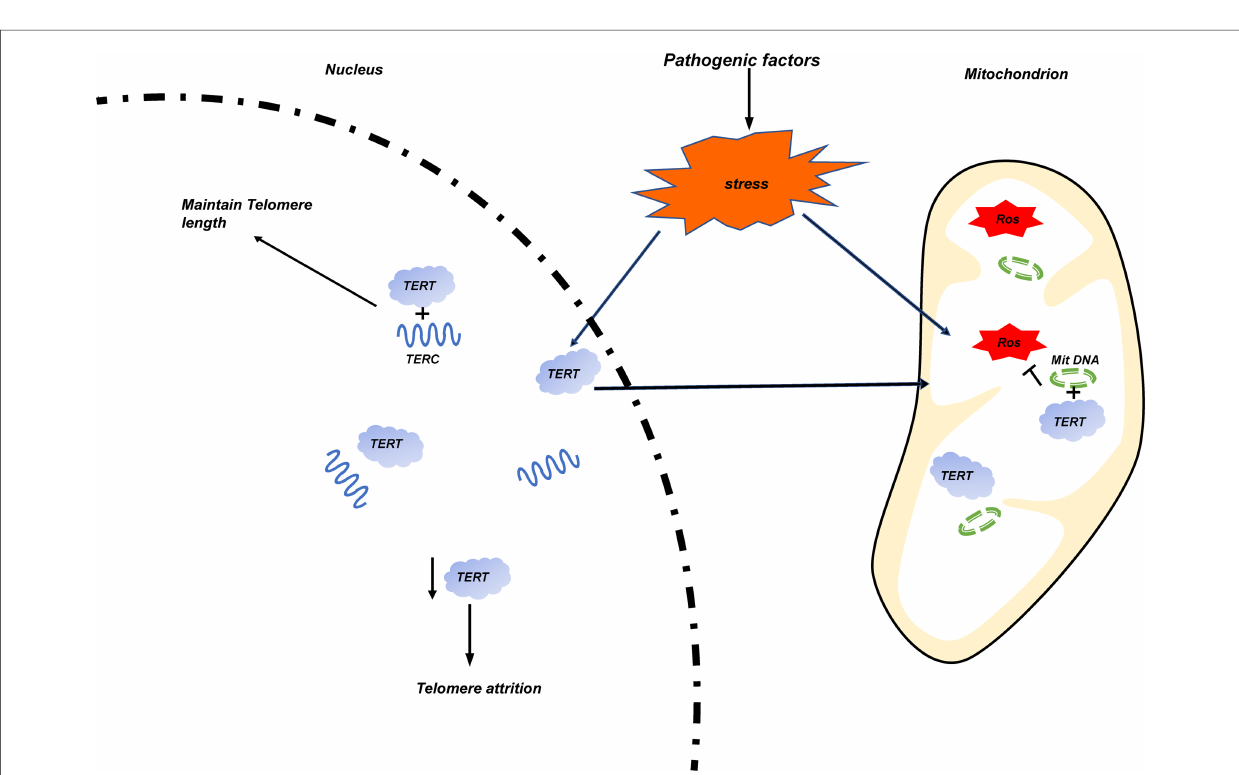
FIGURE 4 The occurrence of stress events is caused by pathogenic factors of various diseases. Mitochondrial damage increases the release of ROS, and TERT transfers from the nucleus to the mitochondria and binds with its circular DNA (Mit DNA) to inhibit the production of ROS. The reduction of the number of TERT in the nucleus leads to the wear of telomere